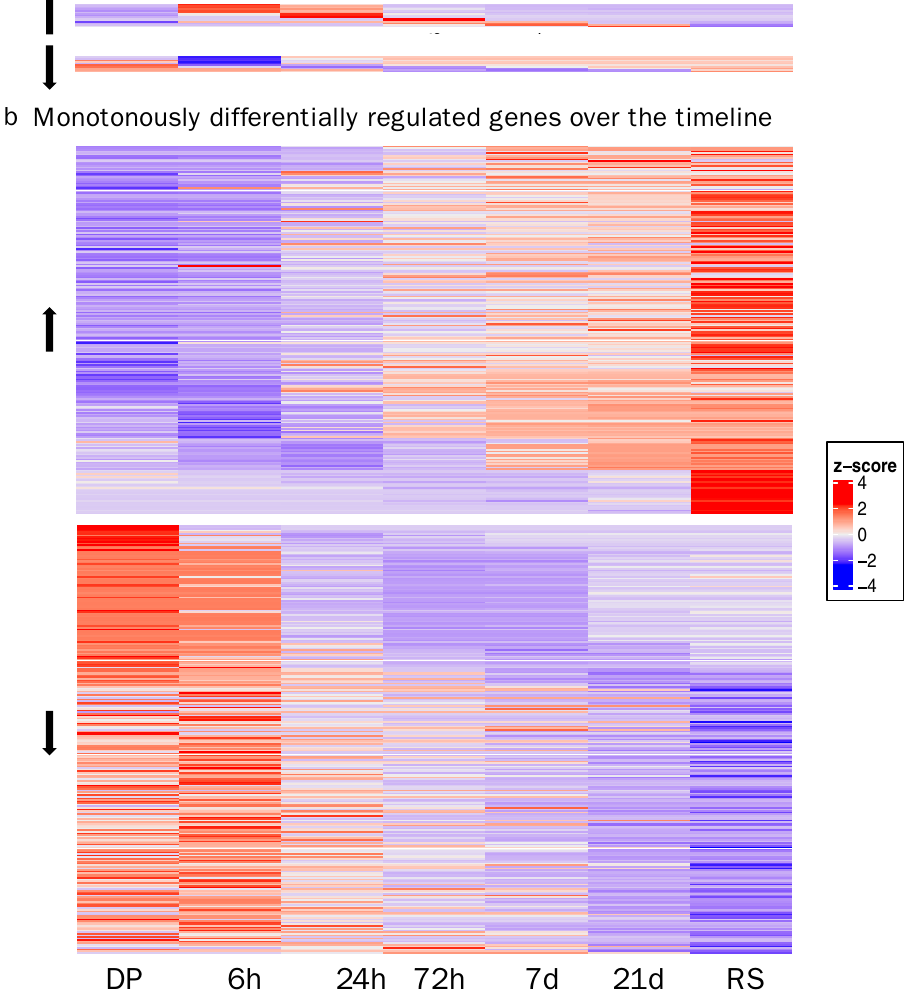
Figure 5. Heatmap of transiently ( a ) or monotonously ( b ) up-( ↑ ) and down- ( ↓ ) regulated differentially expressed genes (FDR corrected p- value < 0.05) over the experimental timeline, as identified by ImpulseDE2 analysis. DP and RS stand for desert pond and Red Sea samples, respectively